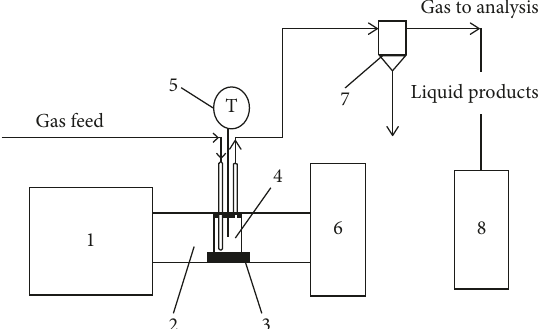
Figure 1: Schematic diagram of the installation for the processing of kraft lignin under the action of microwave radiation. 1: mag- netron and power supply; 2: waveguide; 3: absorbing ceramics; 4: quartz reactor; 5: thermocouple; 6: residual MWI absorption chamber; 7: cooled separator; 8: gas